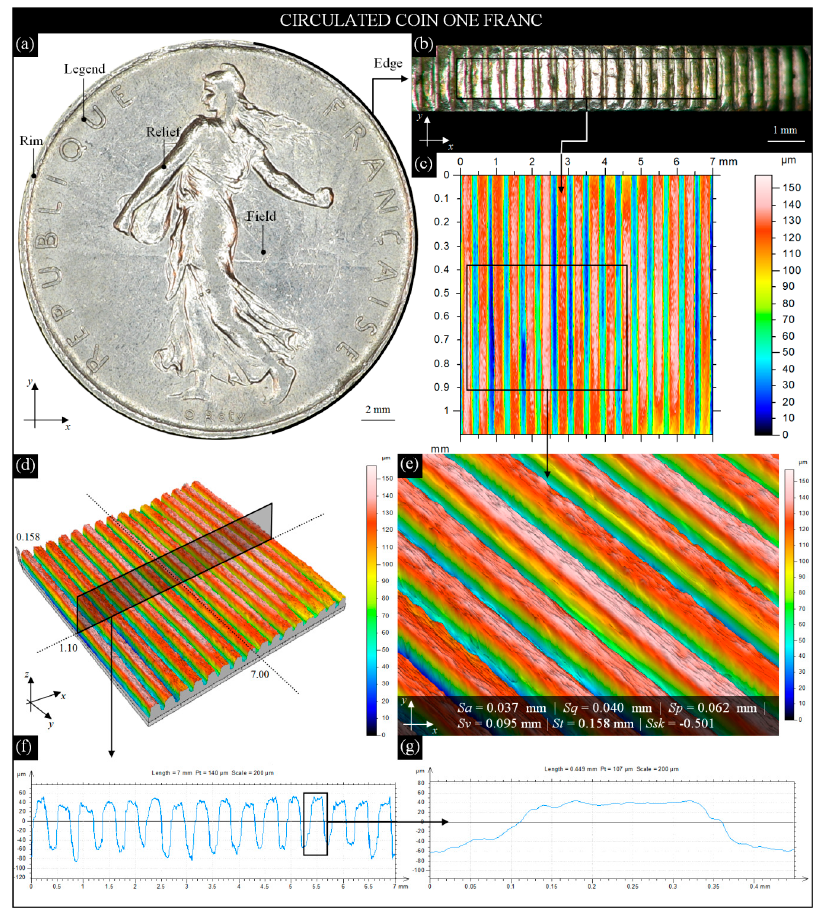
Figure 4. Selected results of observation and analysis of the surface condition of modern circulated French 1 franc coin obtained by the digital microscope Omni Core (Ash Technologies Ltd., Kildare, Ireland) and 3D optical profilometer S neox (Sensofar Metrology, Terrassa, Spain): ( a ) general view of coin obverse; ( b ) an image (10.93 × 1.79 mm) of a fragment of the coin’s reeded edge; ( c ) a 2D height map (indexed colors) of the AOI (7.11 × 1.10 mm) from Figure 4b; ( d ) surface microtopography (7.11 × 1.10 × 0.15 mm); ( e ) close-up view (4.49 × 0.51 mm) of the reeded edge with calculated amplitude (surface) parameters; ( f ) extracted from Figure 4d, a single surface profile with visible grooves; ( g ) extracted from Figure 4f and enlarged image of a single groove.